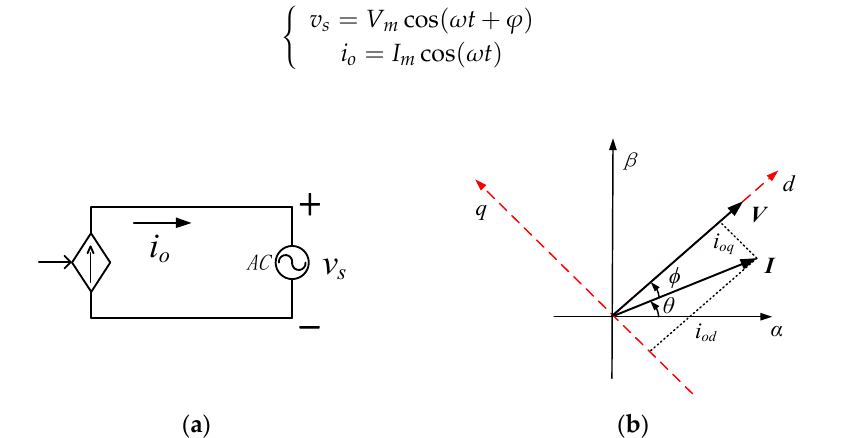
Figure 4. Single-phase DC/AC bi-directional converters work in grid-connected mode. ( a ) Equivalent diagram of single-phase DC/AC bi-directional converter. ( b ) General vector diagram of single-phase DC/AC bi-directional converter.